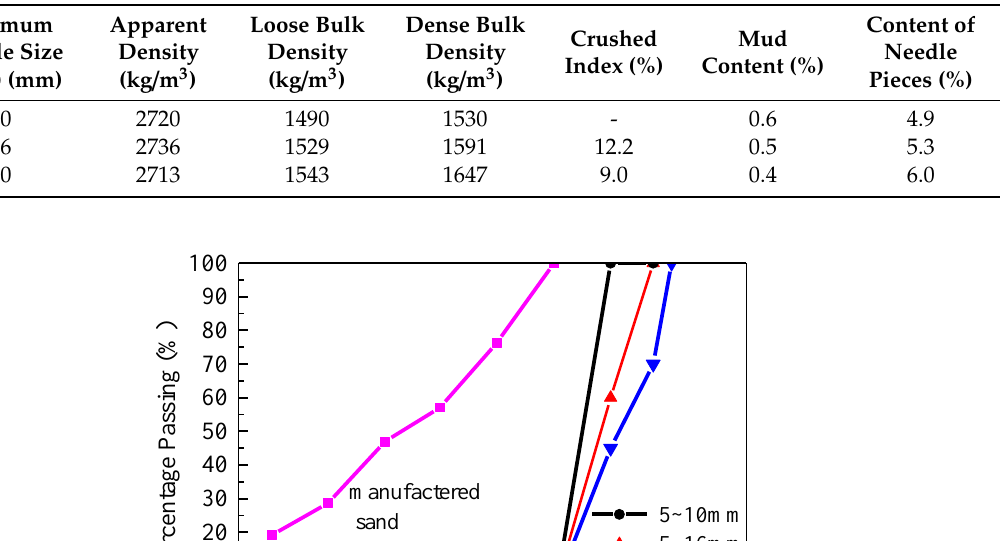
Table 2. Physical and mechanical properties of crushed limestone.